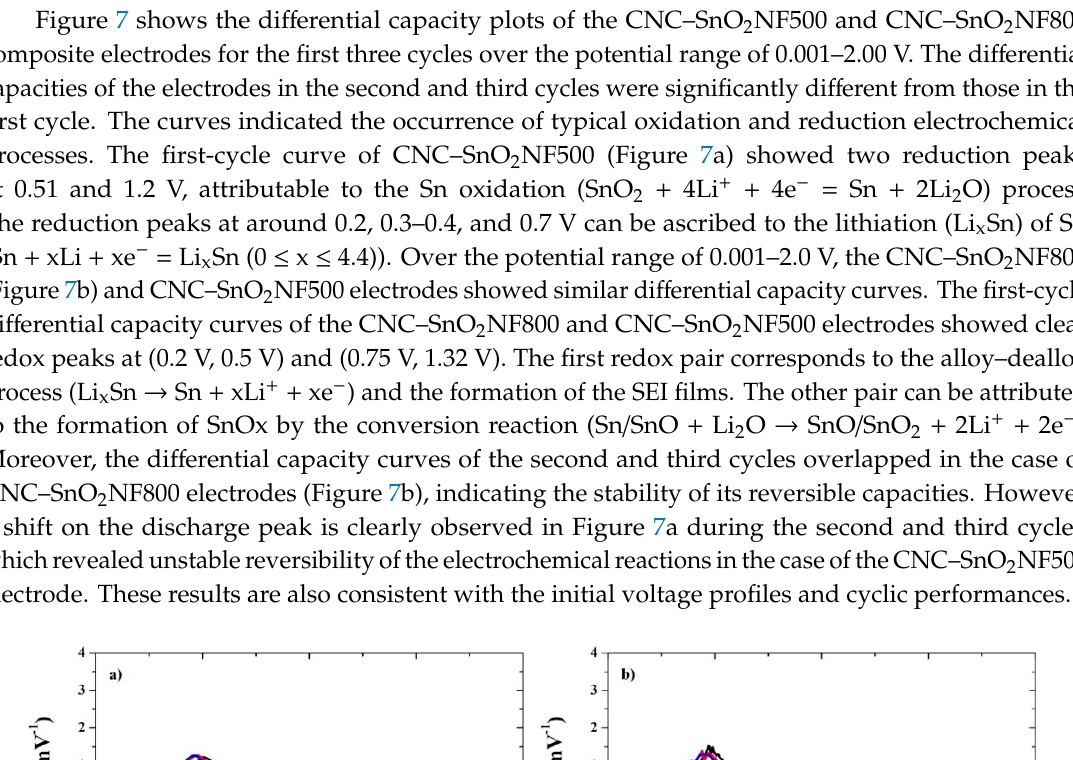
Figure 8. ( a ) Cyclic performance and ( b ) initial voltage profiles of the pyrolyzed CNC electrode at 100 mA g − 1 . The pyrolysis temperature is 800 °C. To further confirm the structural stability of the CNC–SnO 2 NF800 composite, SEM images of it after 200 cycles were obtained (Figure 9). The SEM images of the electrode before and after cycling (200 cycles) are shown in Figure 9a,b, respectively. It can be observed from the images that the